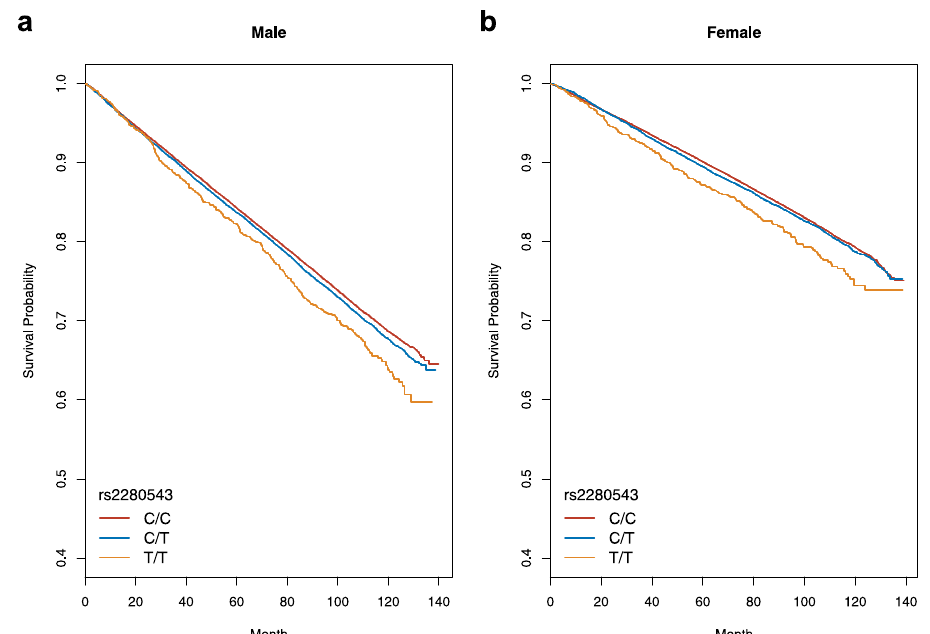
Fig. 3 Survival curves strati fi ed by rs2280543 genotypes in each sex. Survival curves plotted according to rs2280543 genotype in males ( a ) and females ( b